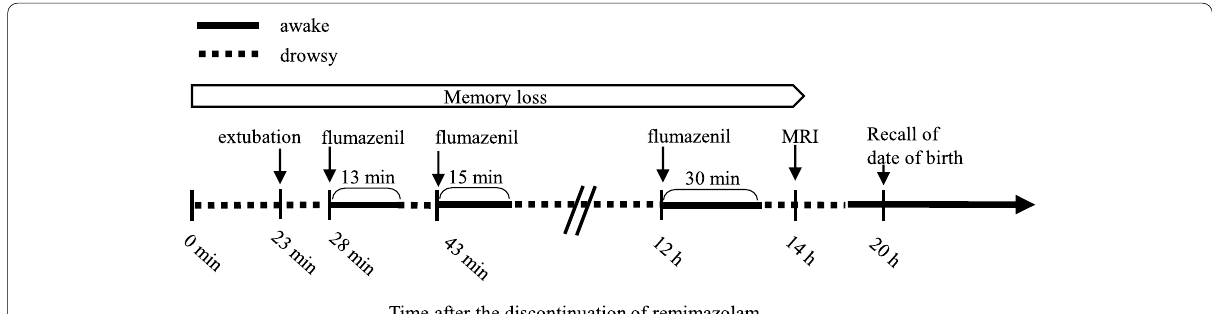
Fig. 1 Changes in postoperative consciousness level over time. Arrows show flumazenil administration timings. Solid lines show awake periods, while dashed lines show drowsy